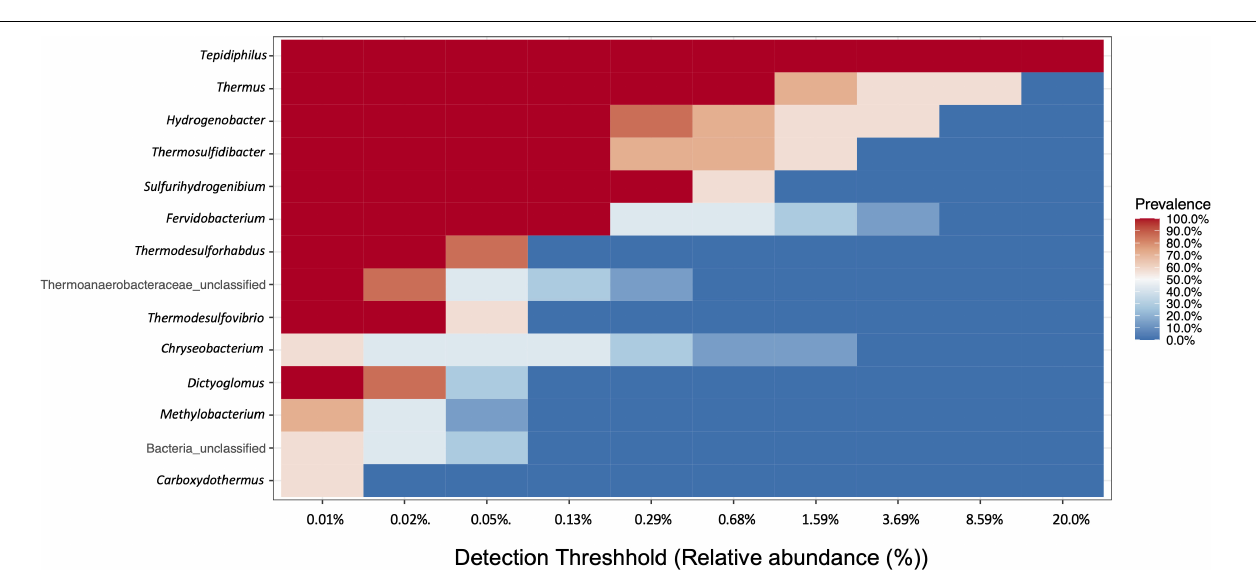
FIGURE 3 | Core community analysis. Heat map representing the genera with prevalence in both water samples (IW and PW). In the X -axis is represented the prevalence of each genus with different detection